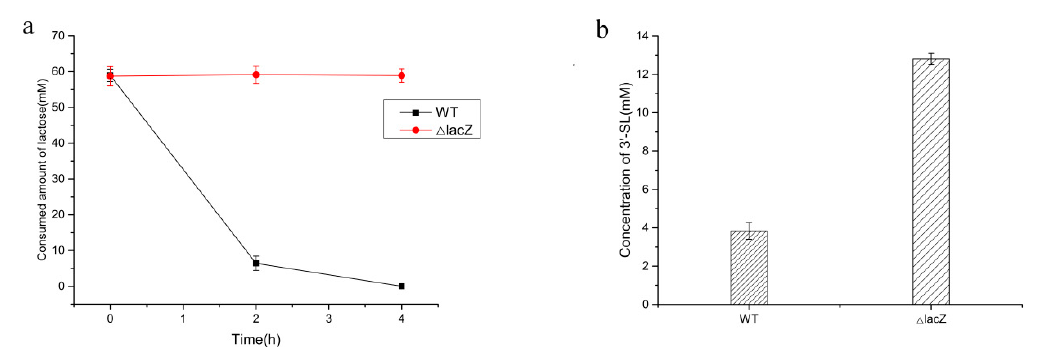
Figure 5. Effect of β -galactosidase deletion. ( a ) Effect of β -galactosidase deletion on the degradation of lactose; ( b ) Effect of β -galactosidase deletion on the production of 3 ′ -SL.